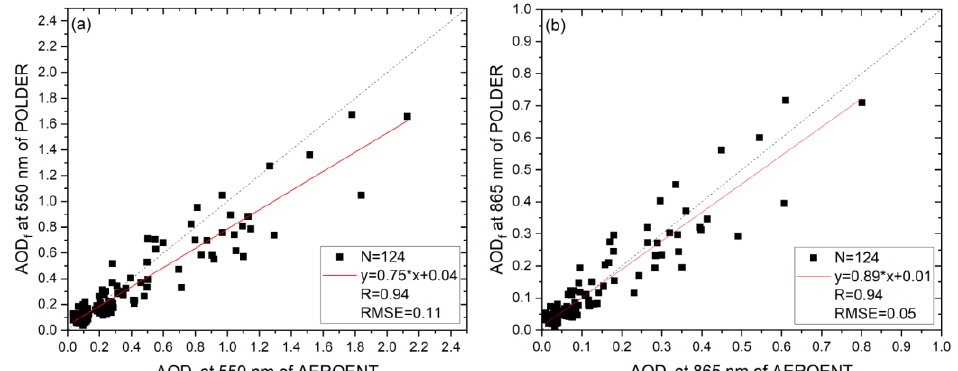
Figure 5. Validation of POLDER AOD f products against two typical sites AERONET measurements for a year, (a) is the AOD f at 550 nm, (b) is the AOD f at 865